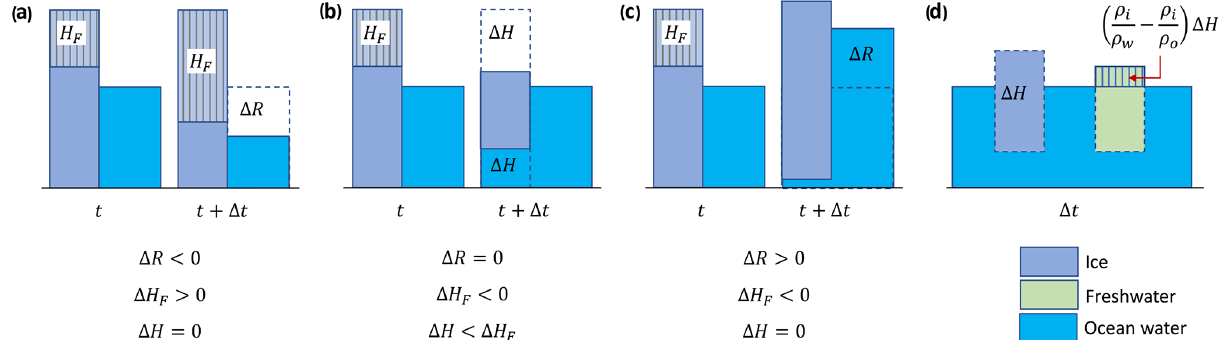
Figure A1. Scenarios of ice-thickness and RSL change and sea-level contributions. (a) Since the column of ice remains grounded at both times and its thickness does not change over the period, the ice column does not contribute to GMSL change. The HAF method incorrectly predicts GMSL drop because of a positive value of (cid:49)H F in response to the imposed drop in RSL. (b) For the grounded ice to float in the case of fixed RSL, it must thin sufficiently, such that (cid:49)H < (cid:49)H F < 0 holds true, contributing to the GMSL rise. (c) Significant rise in RSL may cause the grounded ice to float even if its thickness does not change. As a result, the column of ice contributes to the GMSL rise. (d) Melting of the floating ice produces freshwater that occupies slightly larger volume than that of the ocean water that was replaced by the ice. This excess volume, the hatched portion of the freshwater column, causes the GMSL to rise. Sketches are not to